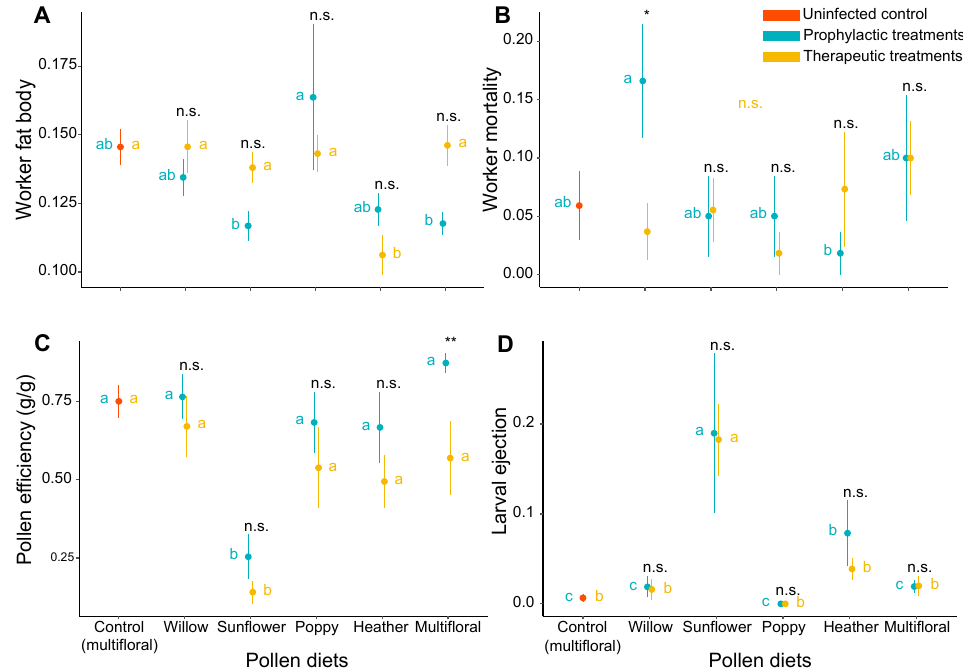
Figure 4. Effects of treatments on B. terrestris micro-colonies. ( A ) Worker fat body, ( B ) Worker mortality, ( C ) Pollen efficiency, and ( D ) Larval ejection. Data in blue represent prophylactic treatments, data in gold represent therapeutic treatments, and data in orange represent the uninfected control (i.e., uninfected microcolonies fed multi fl oral pollen). Points are mean values of each treatment and error bars indicate the standard error of means. Le tt ers indicate signi fi cance at p < 0.05; blue le tt ers refer to comparison across pollen within prophylactic treatments, gold le tt ers refer to comparisons across pollen within therapeutic treatments, and statistical signi fi cance code refers to comparisons between treatments (prophylactic vs. therapeutic) (n.s., p > 0.05; *, p < 0.05; **, p < 0.01). Pairwise comparisons were performed based on a priori contrasts.